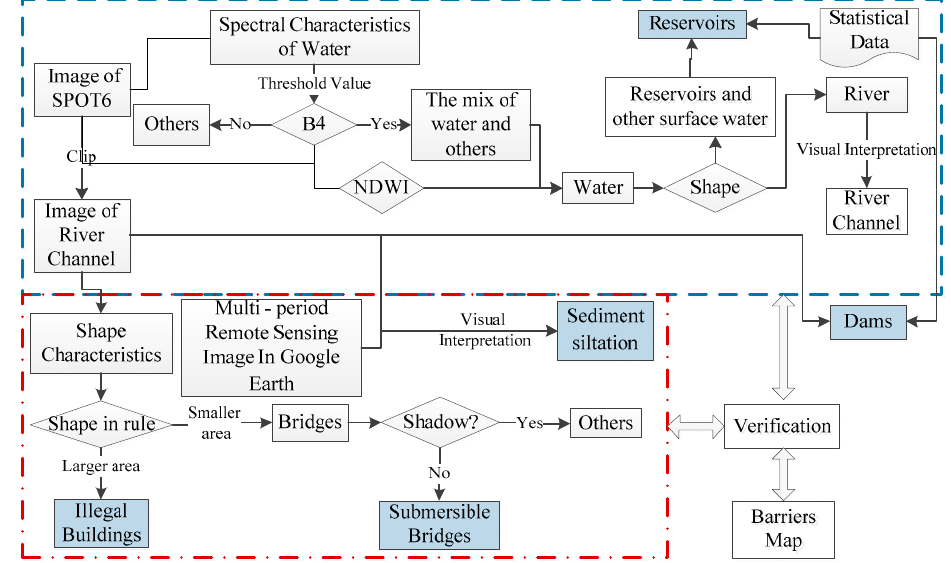
Figure 3. The technical flowchart for the identification of river channels and barriers. Table 2. The barriers in the field landscape and remote sensing imagery.